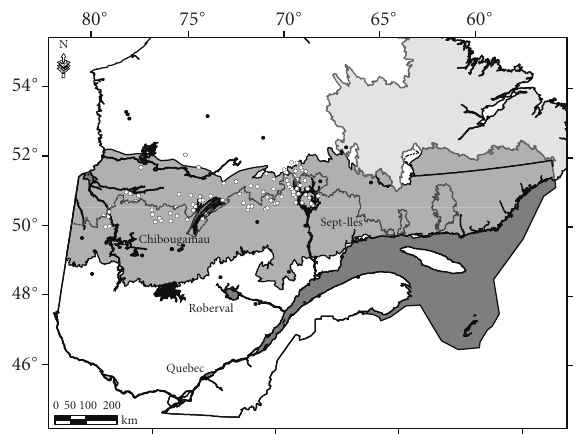
Figure 1: Location of the 147 forest permanent sample plots (white circles) located above the 50th parallel, and meteorological stations (black circles) used to generate climatic conditions at each plot. Note that several plot locations are superimposed due to the map scale. The shaded area corresponds to the black spruce-moss bioclimatic domain, while the grey hatched line corresponds to the limit of the current managed forest area in Quebec,